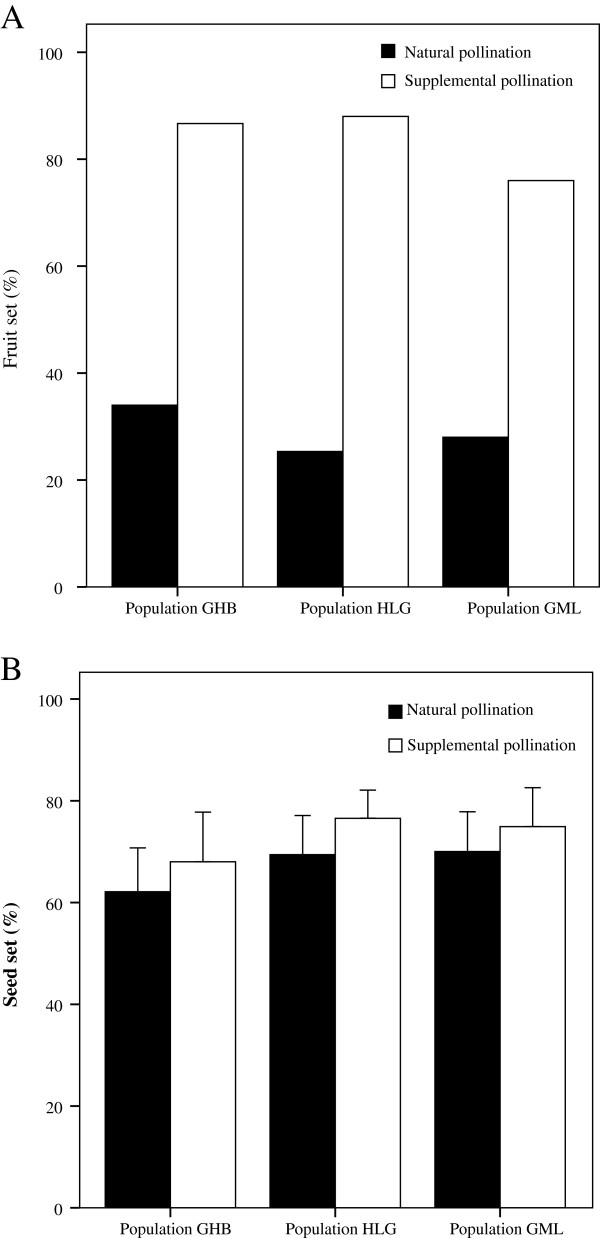
Comparison of fruit (A) and seed set (B) between natural pollination and supplemental pollination treatments. Bars with different letters differ statistically at P < 0.05. Black bars: natural pollination; grey bars: supplemental pollination.